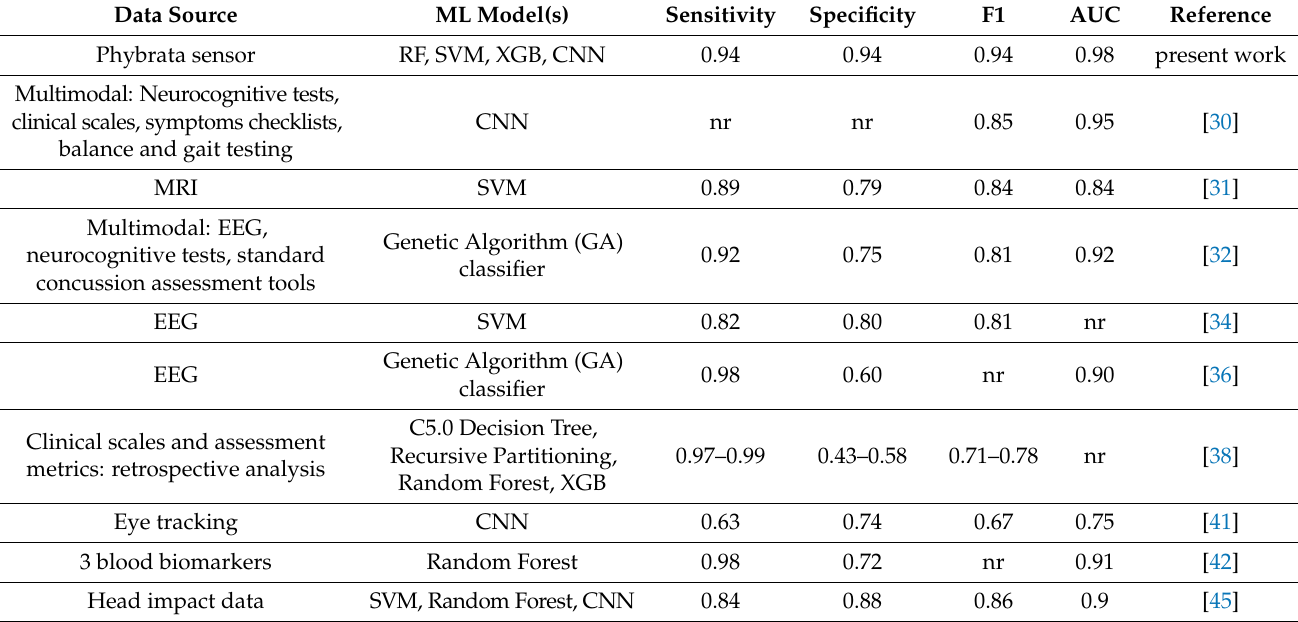
Table 3. Comparison of results for binary classification of concussion patients (nr = not